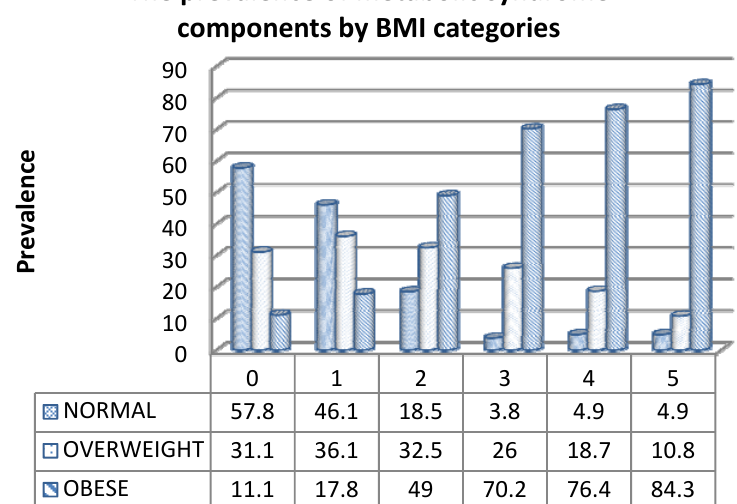
With MetS* = presence of ≥ 3 metabolic syndrome